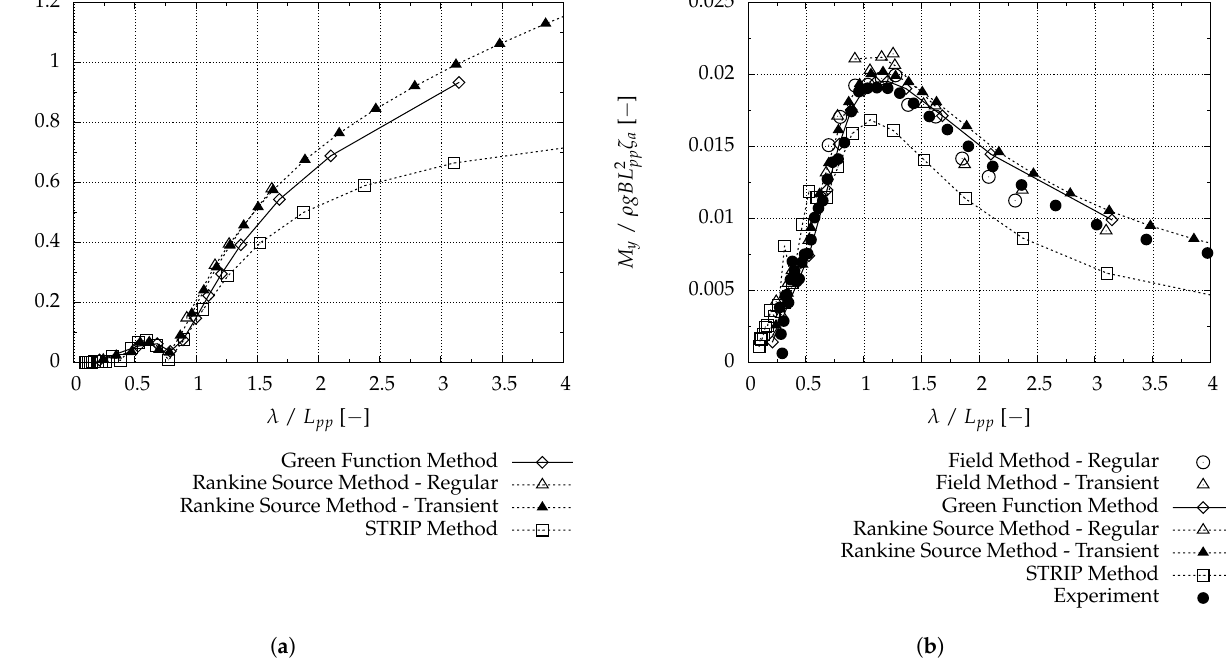
Figure 12. Chemical tanker: computed and measured RAOs, ( a ) surge motion ξ and ( b ) midship vertical bending moment M y . ρ is the water density, g the gravity constant, B the ship’s breadth and L pp the ship